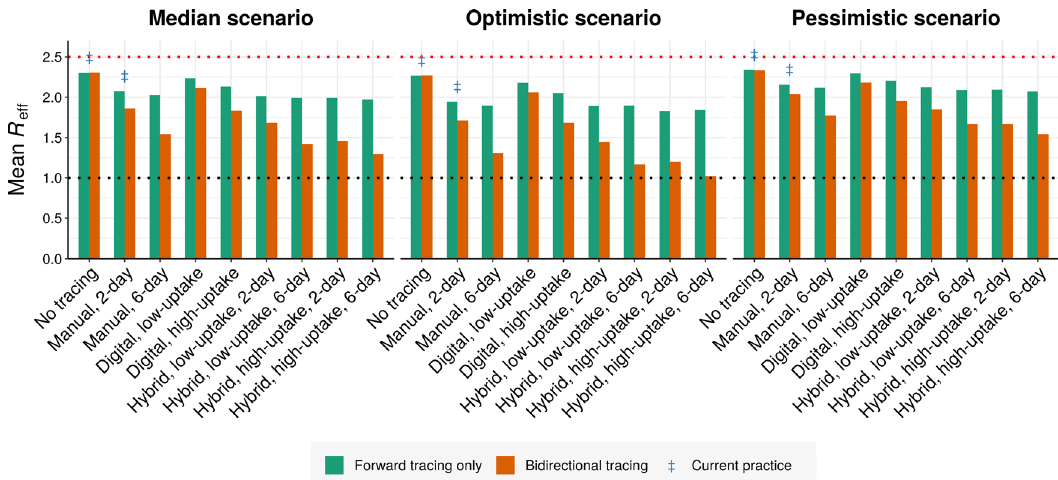
Fig. 5 Performance of different tracing strategies relative to current practice. Mean effective reproduction number obtained under (left) median, (middle) optimistic, and (right) pessimistic scenarios (Table 1), assuming an R 0 of 2.5 and a 90% baseline probability of trace success across 1000 runs. Blue double dagger symbols indicate conditions roughly corresponding to current practice in most regions. Low and high uptake correspond to 53% and 80% of cases, respectively, having chirp-enabled smartphones. Without tracing, forward and bidirectional are